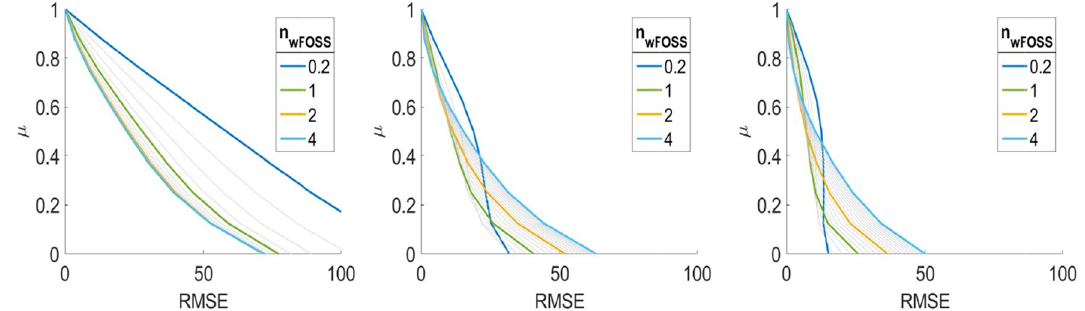
Fig. 11 Branin function: Average RMSE over the 𝛼 -cuts of the result space for the RBF model with 100 underlying FOSS sampling plans with 4 (left), 9 (center), and 16 (right) sampling